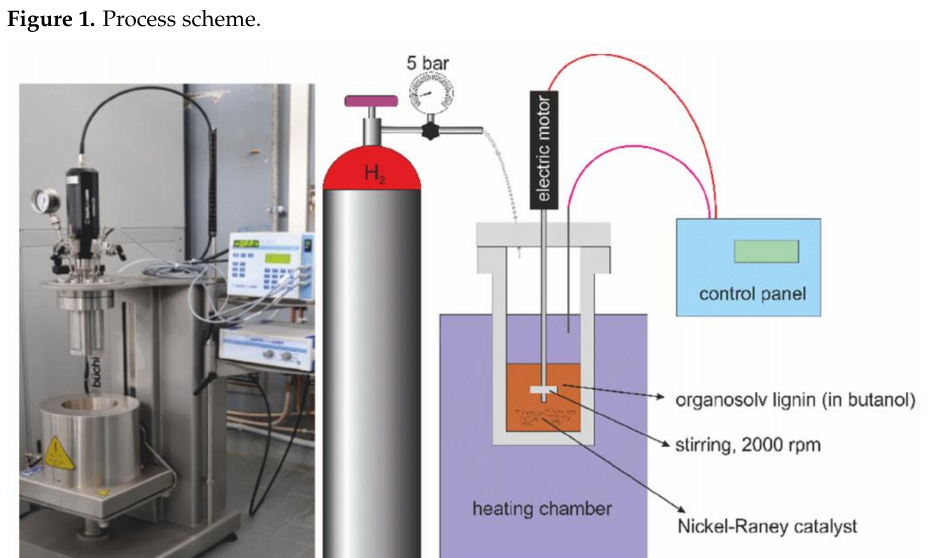
Figure 1. Process scheme.